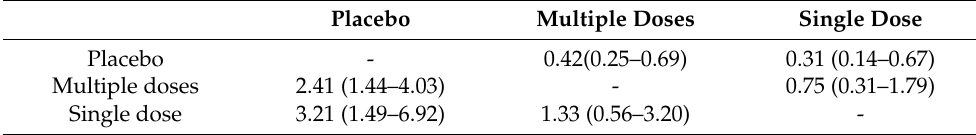
Figure 2. Forest plot of the network meta-analysis for reintubation rate. Table 3. League table for networks according to steroid administration frequency.